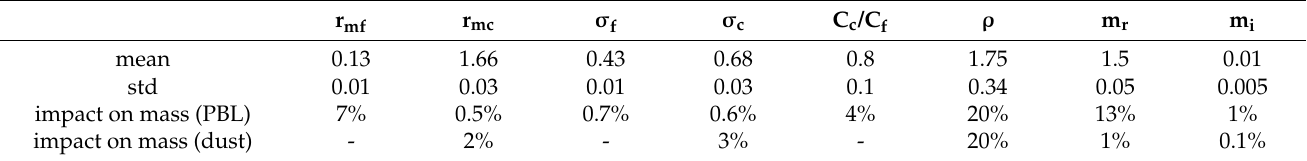
Table 4. Parameters used for the calculations of mass concentration profiles: modal radius for fine r mf and coarse r mc modes, in µ m; the geometric standard deviation for fine σ f and coarse σ c modes; the ratio of volume concentration of coarse to fine modes C c /C f ; the particle density ρ in g/cm 3 ; the real part of the refractive index m r ; and the imaginary part of the refractive index m i